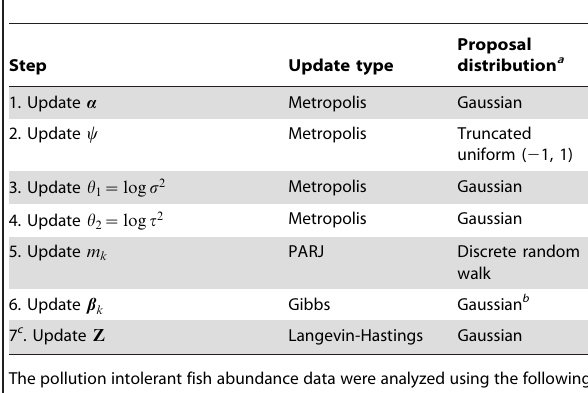
Table 1. Steps in PARJ algorithm for geostatistical regression